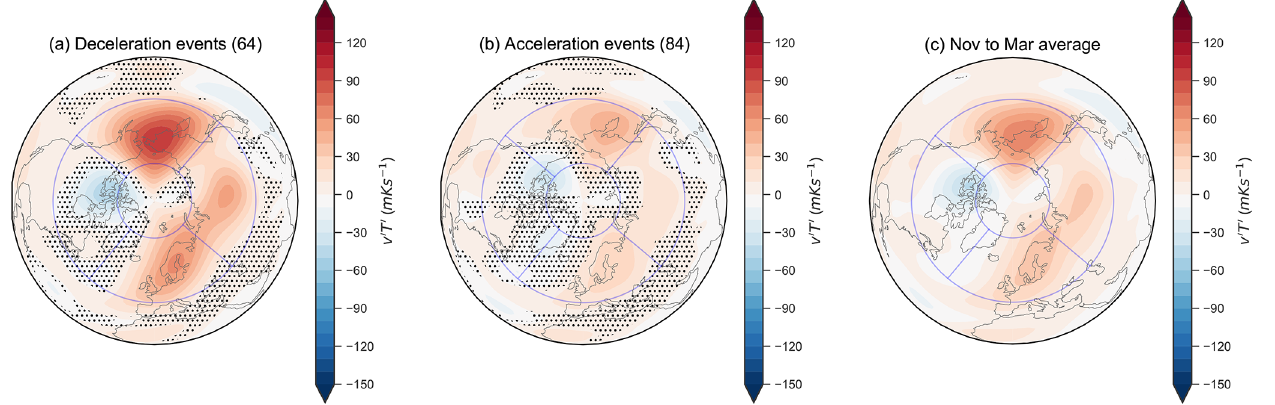
Figure A4. Composite v (cid:48) T (cid:48) at 100hPa averaged over day 0 to 9 (during the event window) of (a) deceleration events, (b) accelera- tion events and (c) November to March average in reanalysis. Blue lines mark the regions of investigation: northern Europe (40 ◦ W– 50 ◦ E), Siberia (50–140 ◦ E), North Pacific (140 ◦ E–130 ◦ W) and North America/Greenland (130–40 ◦ W). Numbers in parentheses indicate the number of events in the composite, and unhatched re- gions in (a) and (b) indicate areas found to be significantly different from (c) using a t test.